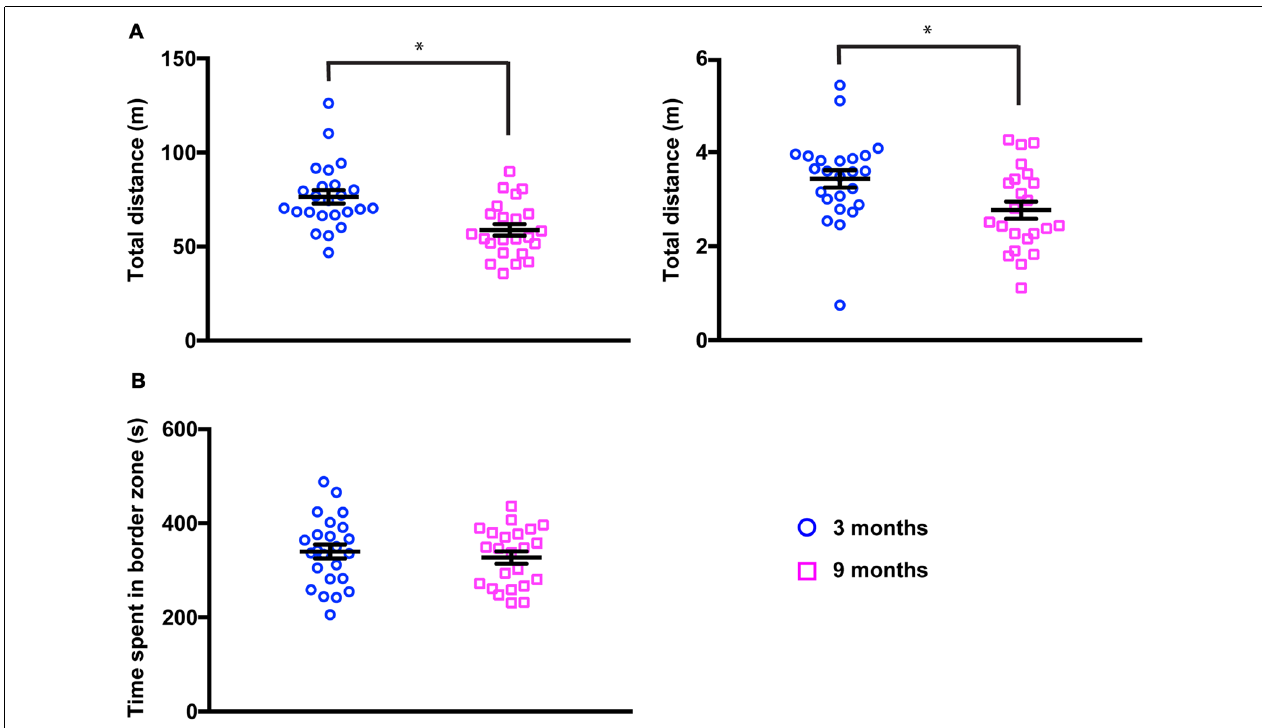
FIGURE 2 | Locomotion is reduced in 9-month-old mice. (A) Total distance traveled in the PhenoTyper (20-h period, left panel) and in the open field (10-min period, right panel) was significantly decreased in 9-month-old mice (3 months, Phenotyper 76.48 ± 3.54 m, open field 3.43 ± 1.86 m; 9 months, PhenoTyper 58.84 ± 3.04 m, open field 2.77 ± 1.83 m). PhenoTyper ∗ p = 0.0026, open field ∗ p = 0.0219 (Kolmogorov-Smirnov test). (B) Time spent in close proximity to the walls of the open field was not modified in 3- vs. 9-month-old mice (3 months, 339.9 ± 14.82 s; 9 months, 327.35 ± 12.90 s).